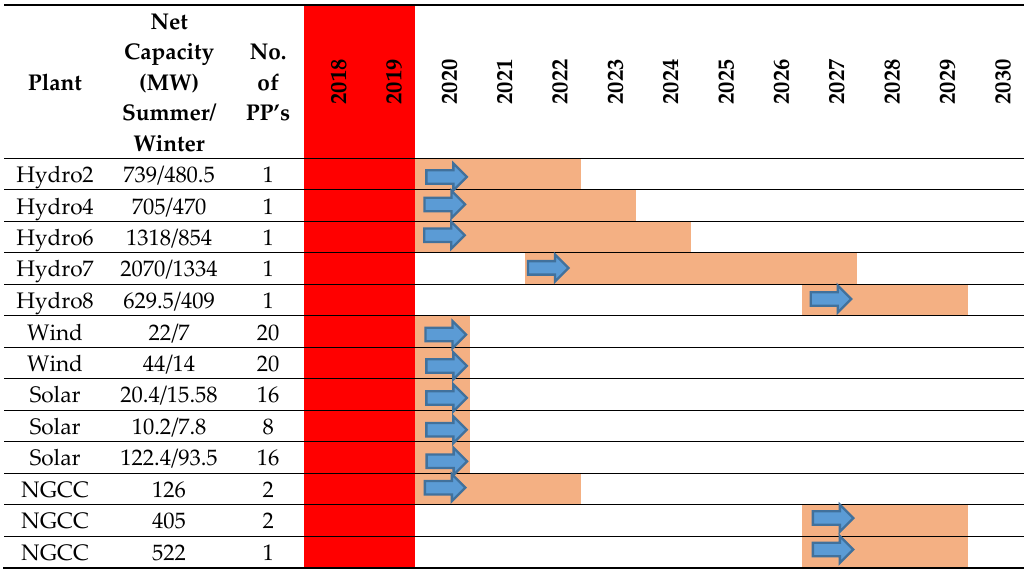
Table A7. Details of the Plants Installation under Capacity Expansion: Normal GDP Fuel Balancing (2–20% Mitigation).